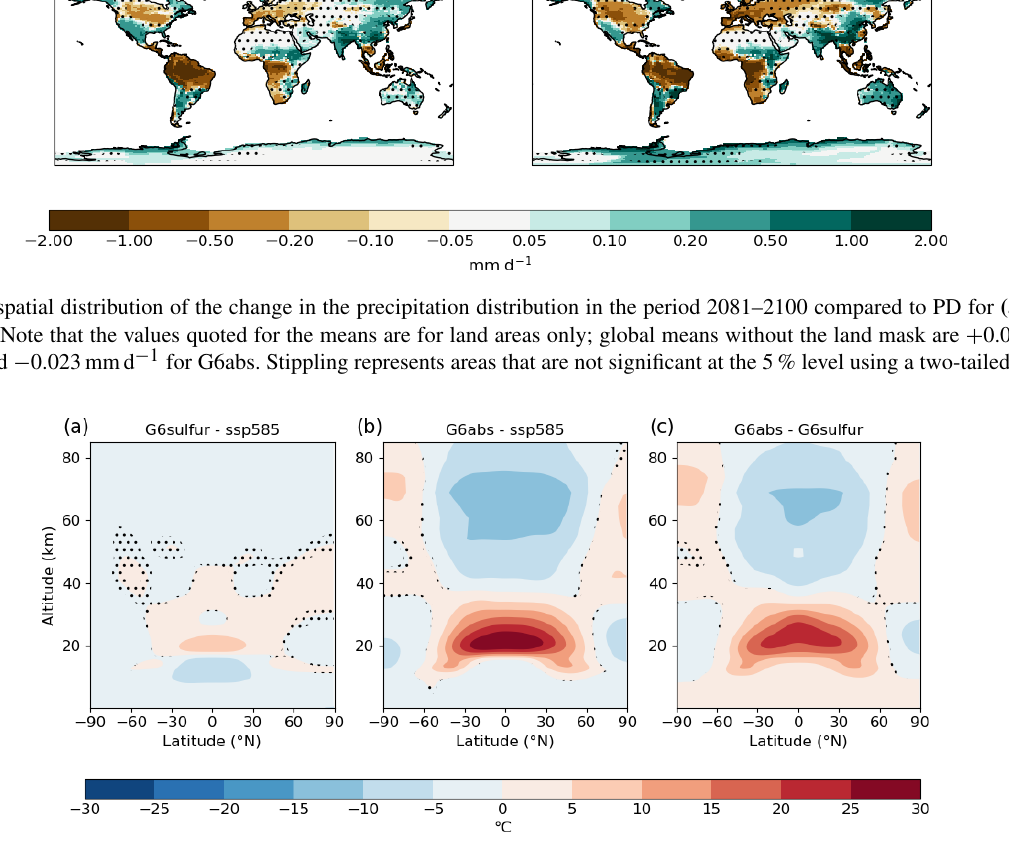
Figure 5. The perturbation to atmospheric temperatures (2081–2100) under (a) G6sulfur compared to SSP5–8.5, (b) G6abs compared to SSP5–8.5, and (c) G6abs–G6sulfur. Stippling represents areas that are not significant at the 5% level using a two-tailed t